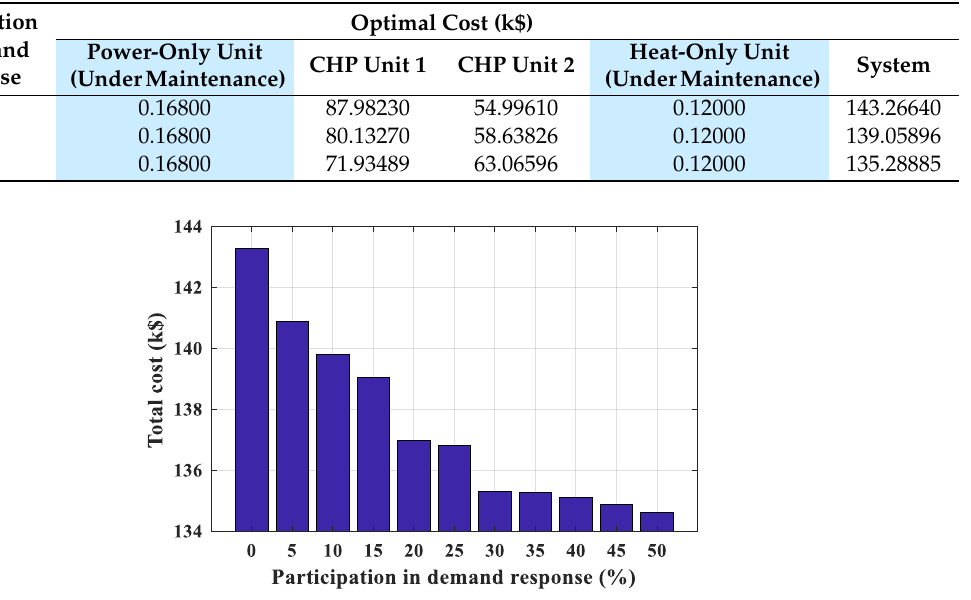
Figure 12. Short-term generation scheduling for a typical day in week 32. Table 10. The units’ cost for different participation percent in demand response for a typical day in the week 32.